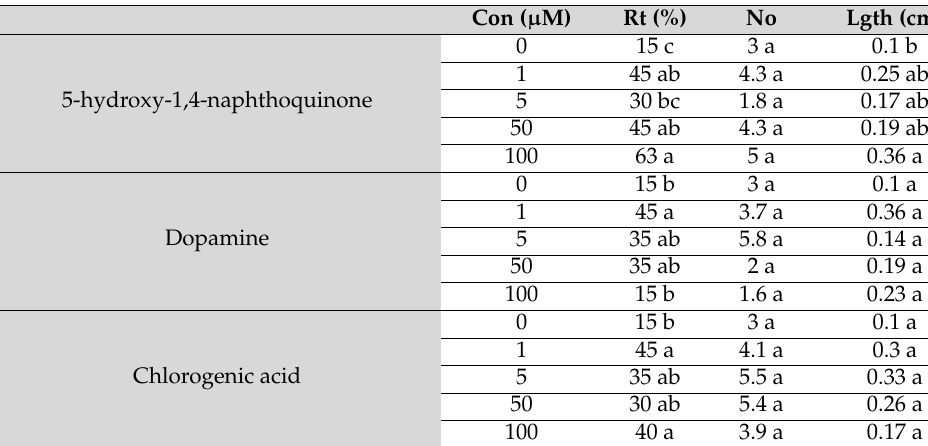
Table 2. Effect of dopamine; 5-hydroxy-1,4-naphthoquinone; and chlorogenic acid on rooting vari- ables of explants cultivated in rooting medium in the presence of IBA.